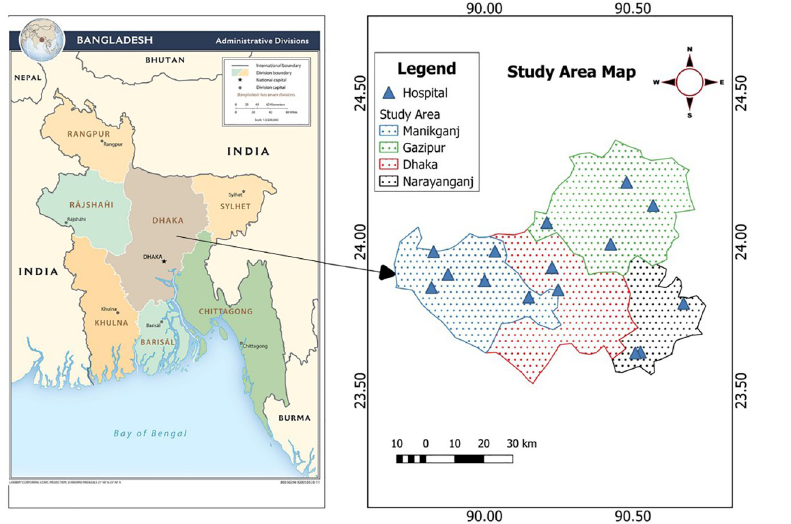
Fig 1. Map of the study